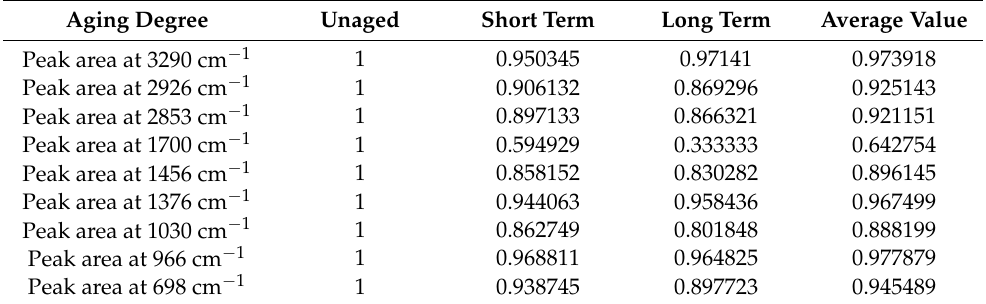
Table 11. Grey correlation degree between CT Index and different peak areas